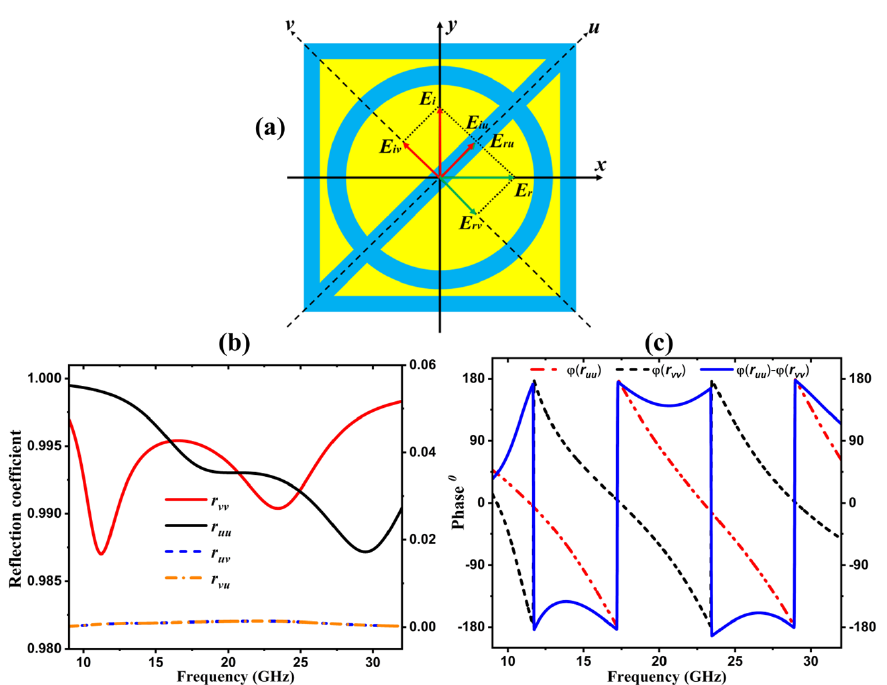
Figure 6. ( a ) Schematic diagram of the proposed meta-atom with uv -coordinates ( b ) magnitude and ( c ) phase of the reflection coefficients of v - and u -waves.